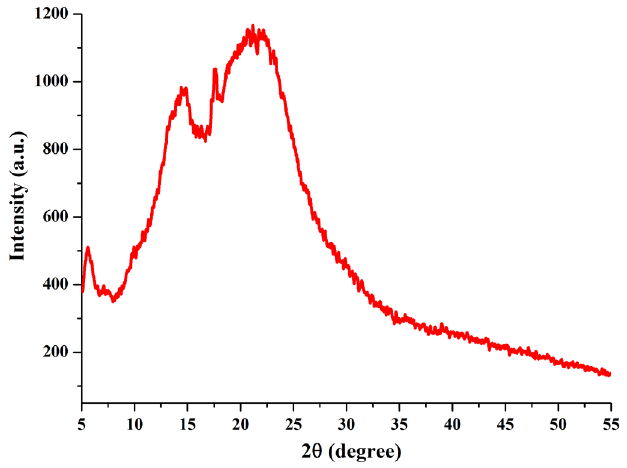
FIGURE 3 - Powder X–ray diffractogram of VAL.